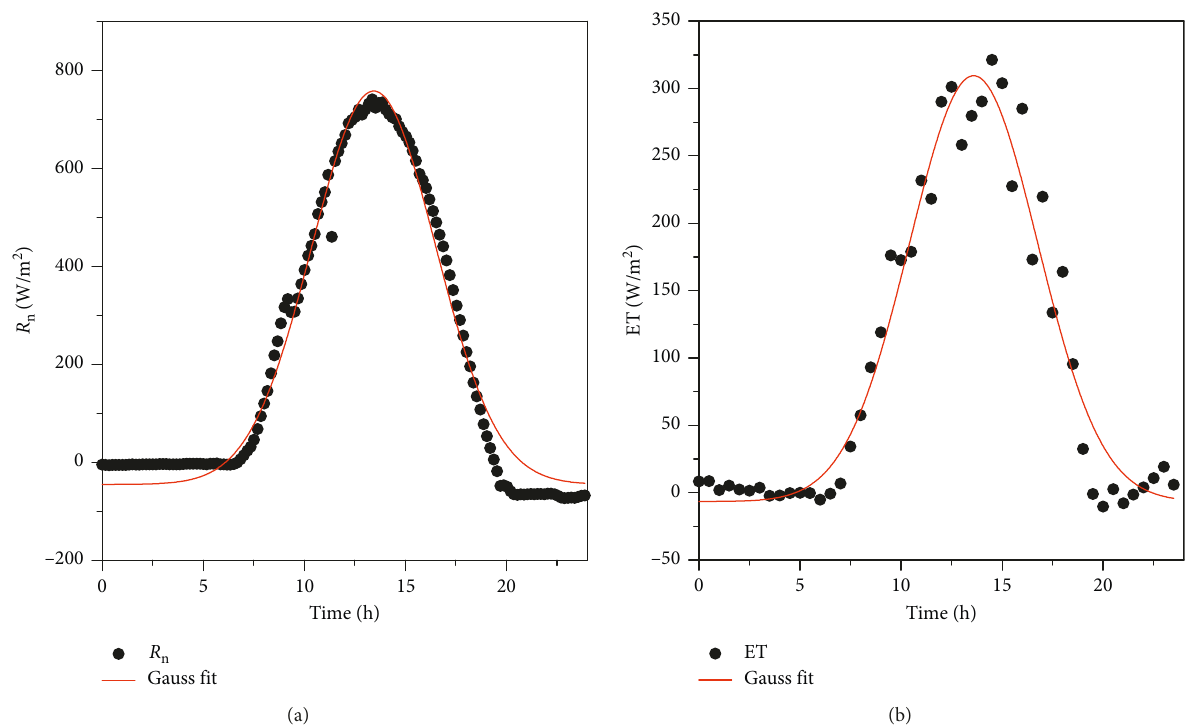
Figure 1: Diurnal course of solar radiation (a) and latent heat flux (b) at middle reaches of Heihe River for a clear sky day: August 14, 2012. Symbols represent experimental data. The lines were calculated from the Gaussian fitting function.